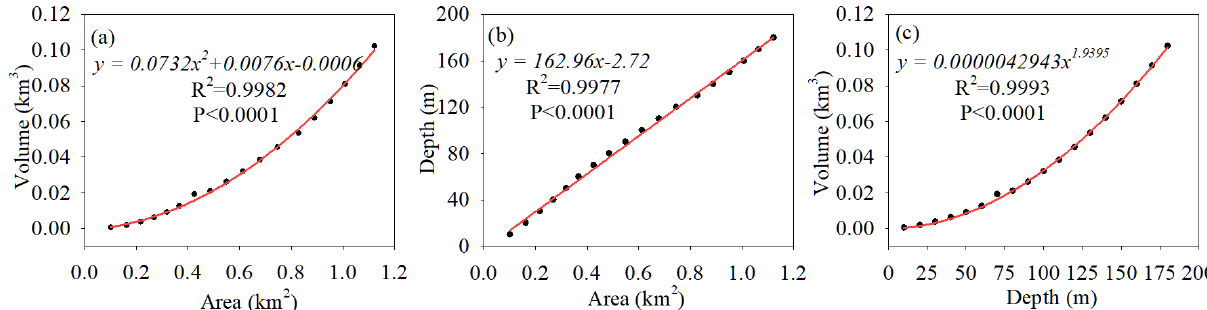
Figure 15. Fitting relationship of (a) area and volume, (b) area and depth, and (c) depth and volume of Bienong